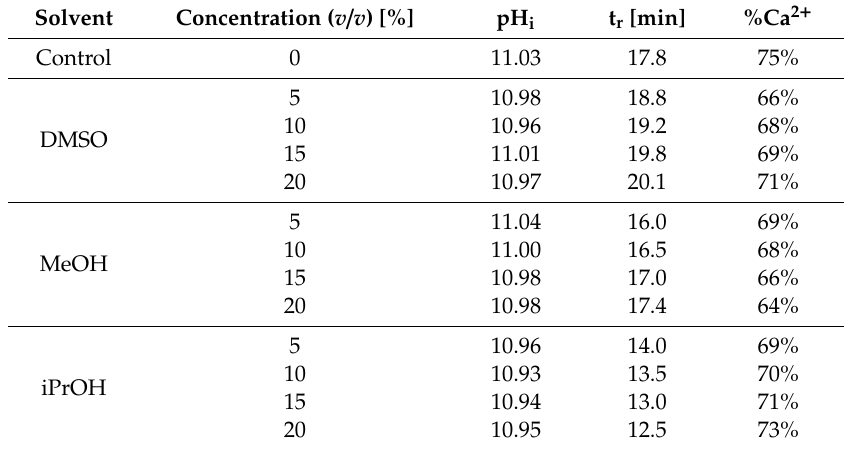
Table 2. The initial pH (pH i ), reaction times (t r ) and the percentage sequestrations of calcium ions ( % Ca 2 + ) depending on the concentration of selected